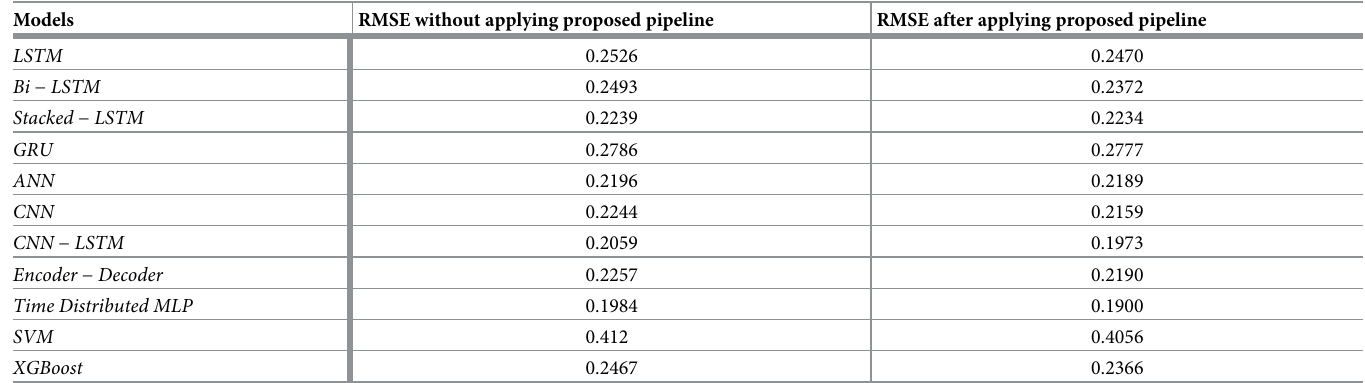
Table 4. RMSE of all the models after applying proposed pipeline.